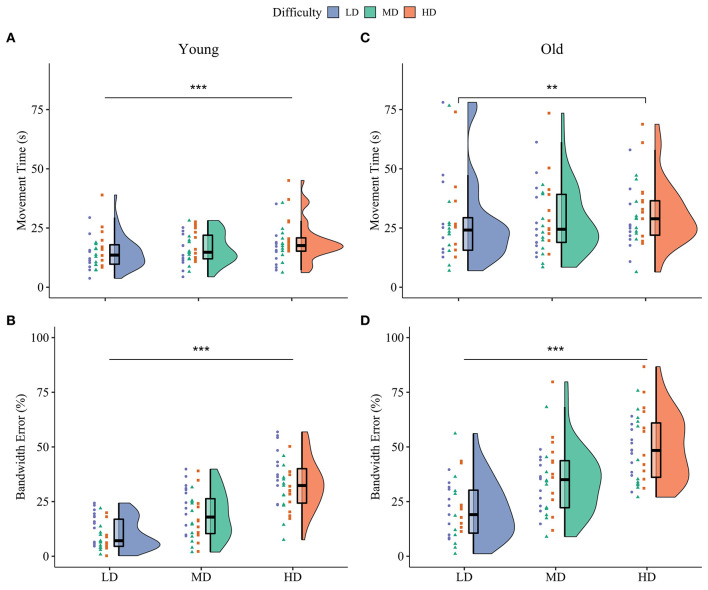
Baseline motor performance on the three difficulty conditions. Both movement time (A) and bandwidth error (B) differed between all three difficulty conditions in younger adults. For older adults, movement time only differed between the low and high difficulty condition (C), while bandwidth error was different for all conditions (D). Violin plots at the right side show the probability density, box-plots in the middle represents the median and interquartile range and dots on the left show individual raw data from the different practice groups. Blue: Low Difficulty (LD), green: Medium Difficulty (MD), orange: High Difficulty (HD). ***p < 0.001, **p < 0.01.